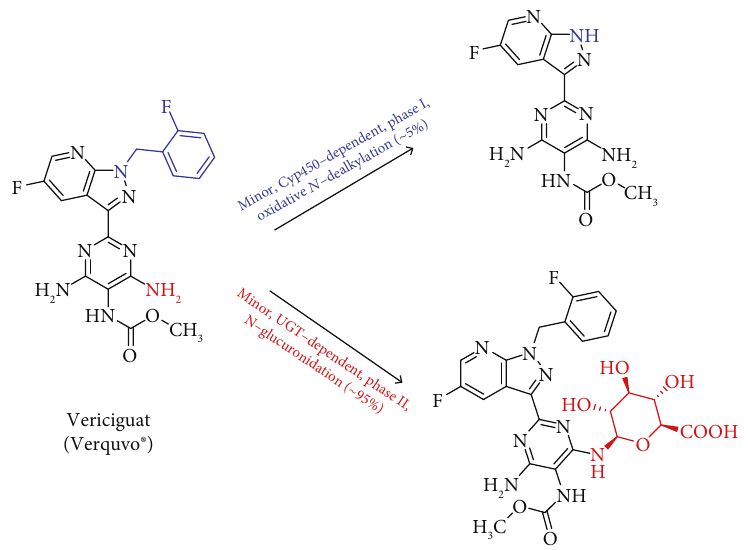
Figure 2: The chemical structure of vericiguat and its reported